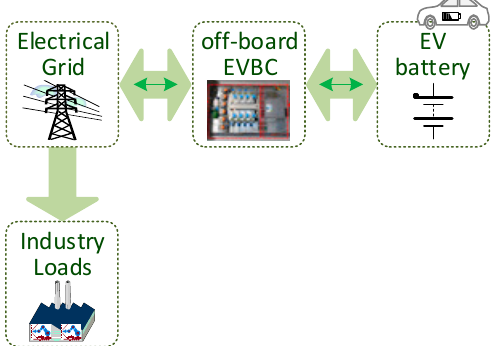
Figure 15. Integration of an off-board EVBC into the electrical power grid for operation as a power quality compensator.